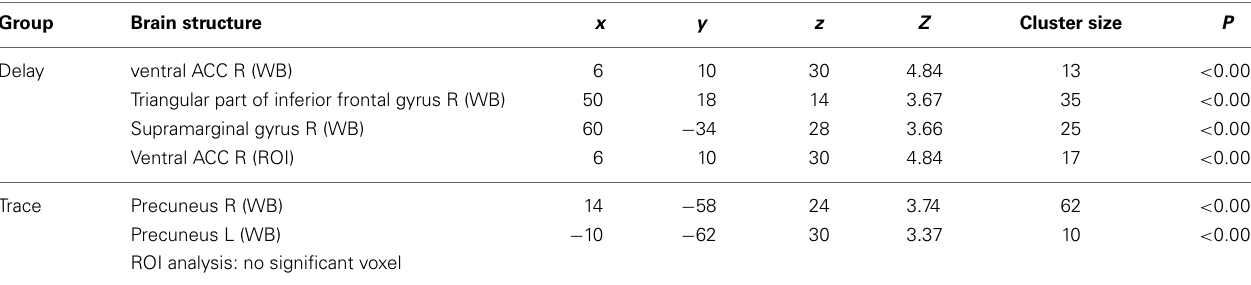
Table 2 | Significant activations revealed by whole brain (WB) and regions of interest (ROI) analysis for contrast CS + > CS − during late